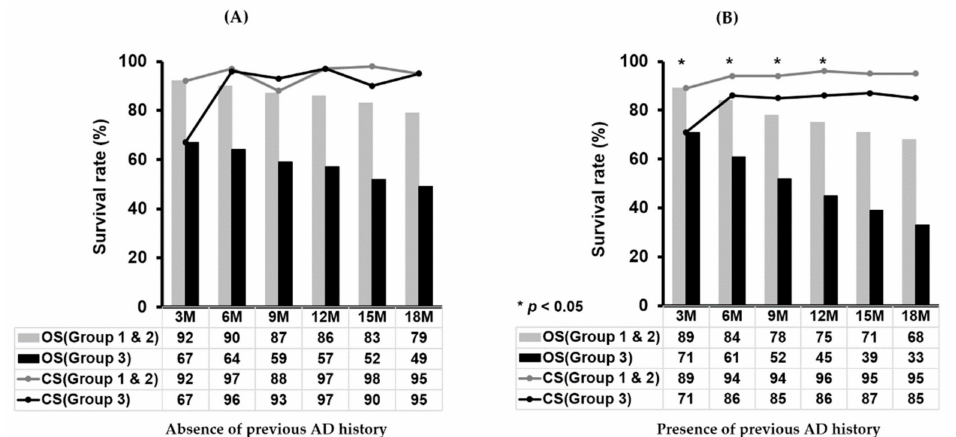
Figure 4. Rates of overall survival and conditional survival in groups 1 & 2 and group 3 regarding the presence of previous AD history. ( A ) In the absence of previous AD history, overall survival rates (bar graphs in black and gray) decreased over time in both groups and were significantly poorer in group 3 compared to groups 1 & 2 ( p < 0.001). However, the three-month conditional survival rates (line graphs in black and gray) were not di ff erent between the two groups after acute deteriorating events. ( B ) In the presence of previous AD history, the overall survival rate in group 3 was significantly poorer than that in groups 1 & 2 (bar graphs in black and gray, p < 0.001). The three-month conditional survival rates of group 3 (line graph in black) were significantly lower than those of groups 1 & 2 (line graph in gray) up to 12 months after acute deteriorating events ( p < 0.05). Asterisks depict that p values were less than 0.05 at each time point. AD, acute decompensation; C.I., confidence interval; CS, conditional survival; HR, hazard ratio; M, months; OS, overall